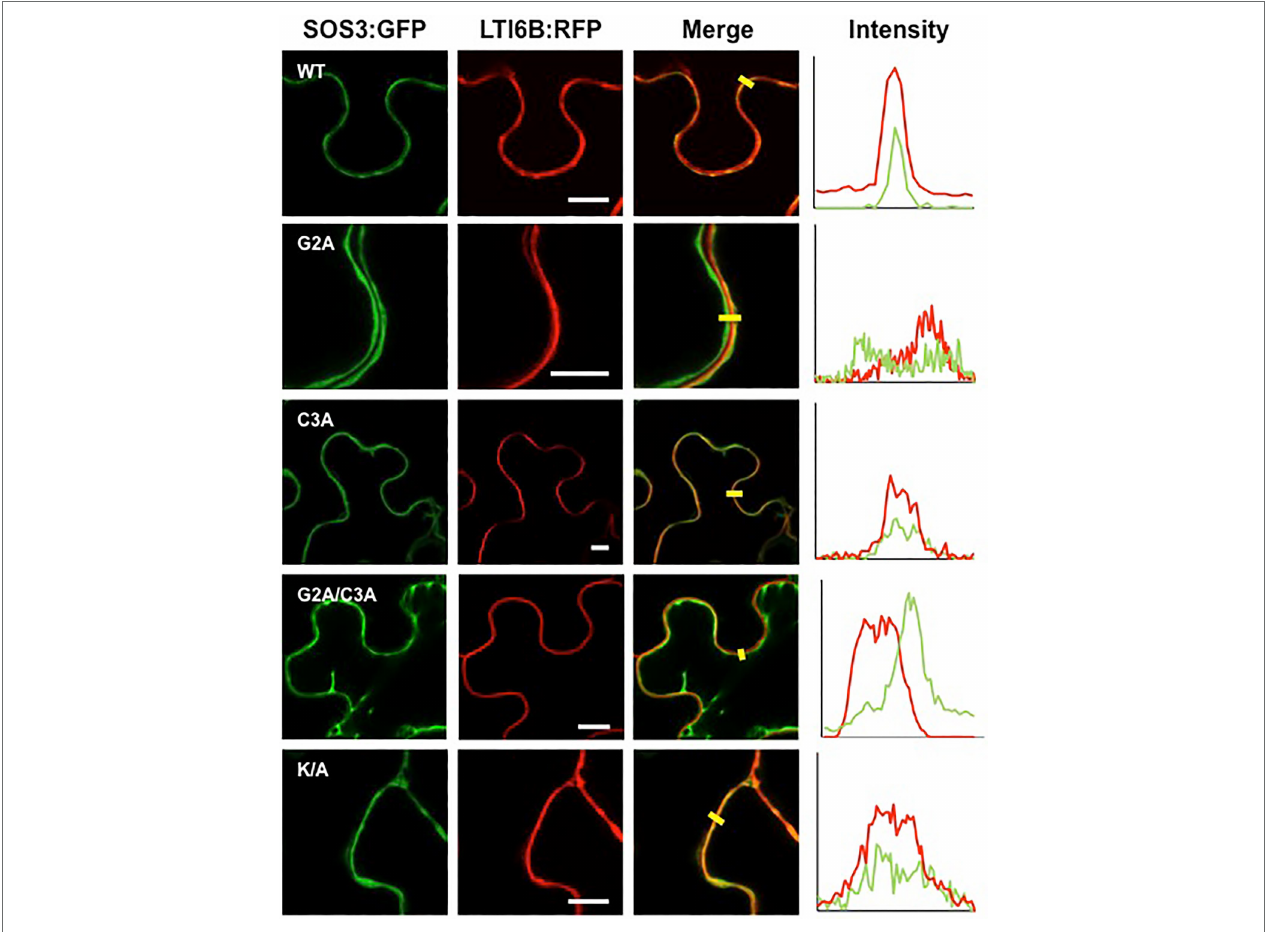
FIGURE 6 | Plasma membrane attachment of SOS3 mutant proteins. Wild-type SOS3 and mutant proteins G2A, C3A, G2A/C3A, and K/A, all fused to GFP, were transiently co-expressed in N. benthamiana with the plasma membrane marker LTI6B:RFP. The plots on the right show the fluorescence intensity in the green and red channels along transects depicted as yellow bars in the micrographs with green and red channels merged. The coincidence of maxima in green and red traces indicates protein co-localization. White bars in middle column = 10 μ